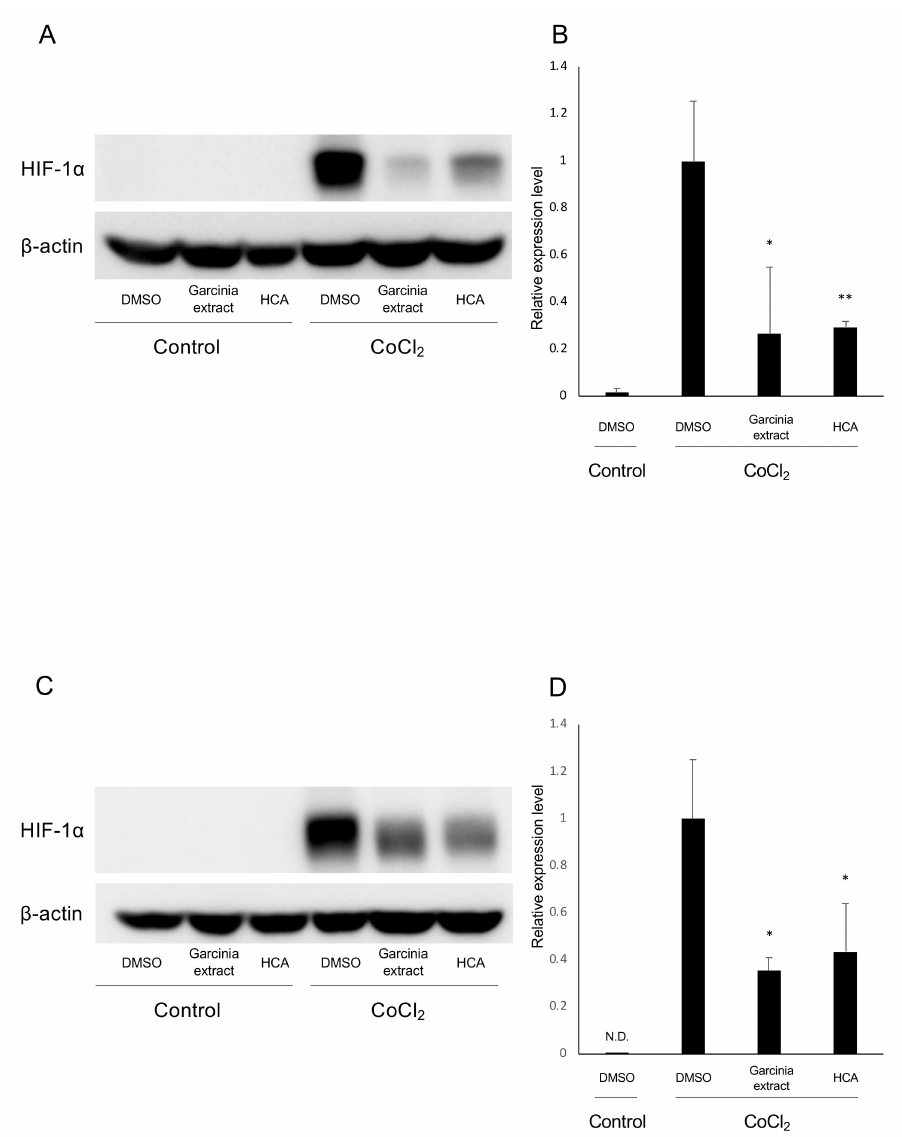
Figure 4. HIF-1 α protein expression is suppressed by Garcinia extract and HCA administration in vitro. ( A ) Western blot for HIF-1 α and β -actin in ARPE19 cells. ( B ) Quantification of the blots showed that the administration of Garcinia extract and HCA significantly suppressed increased HIF-1 α protein expression in ARPE19 cells ( n = 3). ( C ) Western blot for HIF-1 α and β -actin in 661W cells. ( D ) Quantification of the blots showed that the administration of Garcinia extract and HCA significantly suppressed increased HIF-1 α protein expression in 661W cells ( n = 3). N.D.: not detectable. * p < 0.05, ** p <